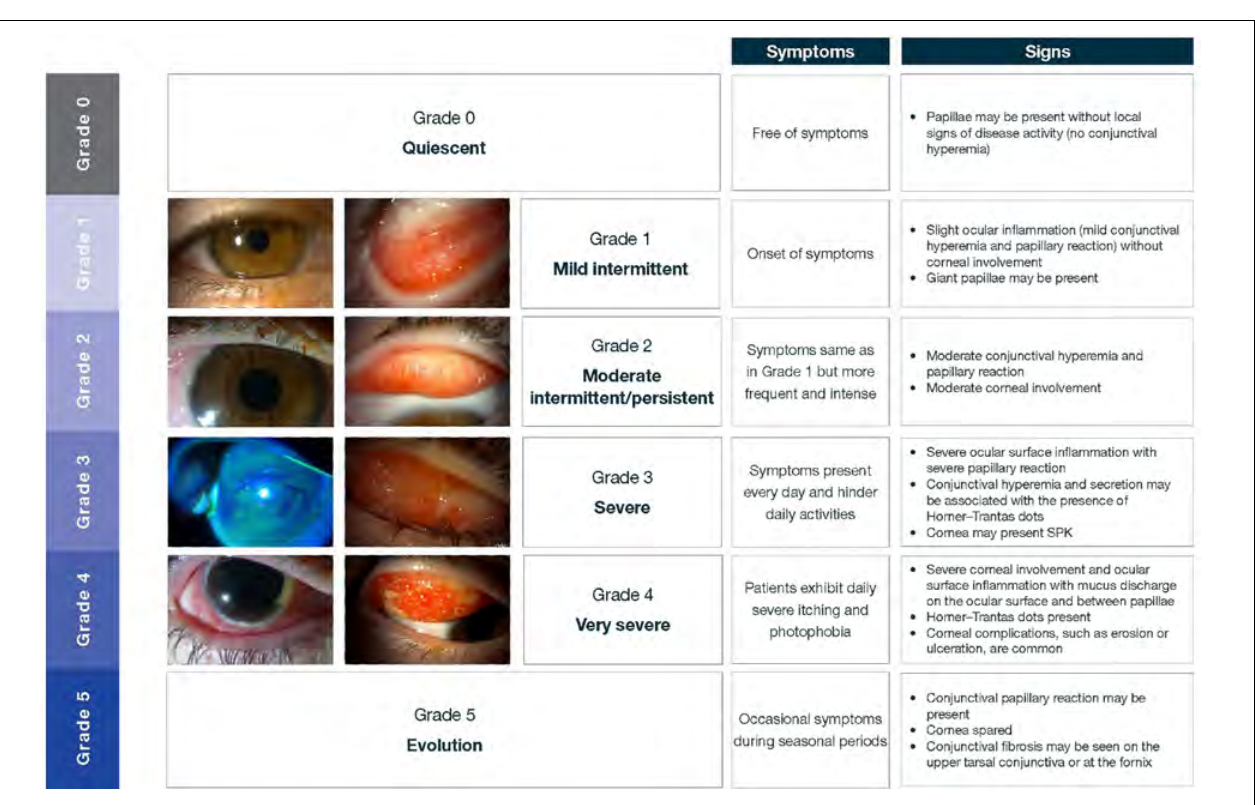
FIGURE 8 | Levels of severity of VKC, based on the Bonini grading scale. Adapted from Bonini et al. (27). Images courtesy of Dominique Bremond-Gignac. SPK, superficial punctate